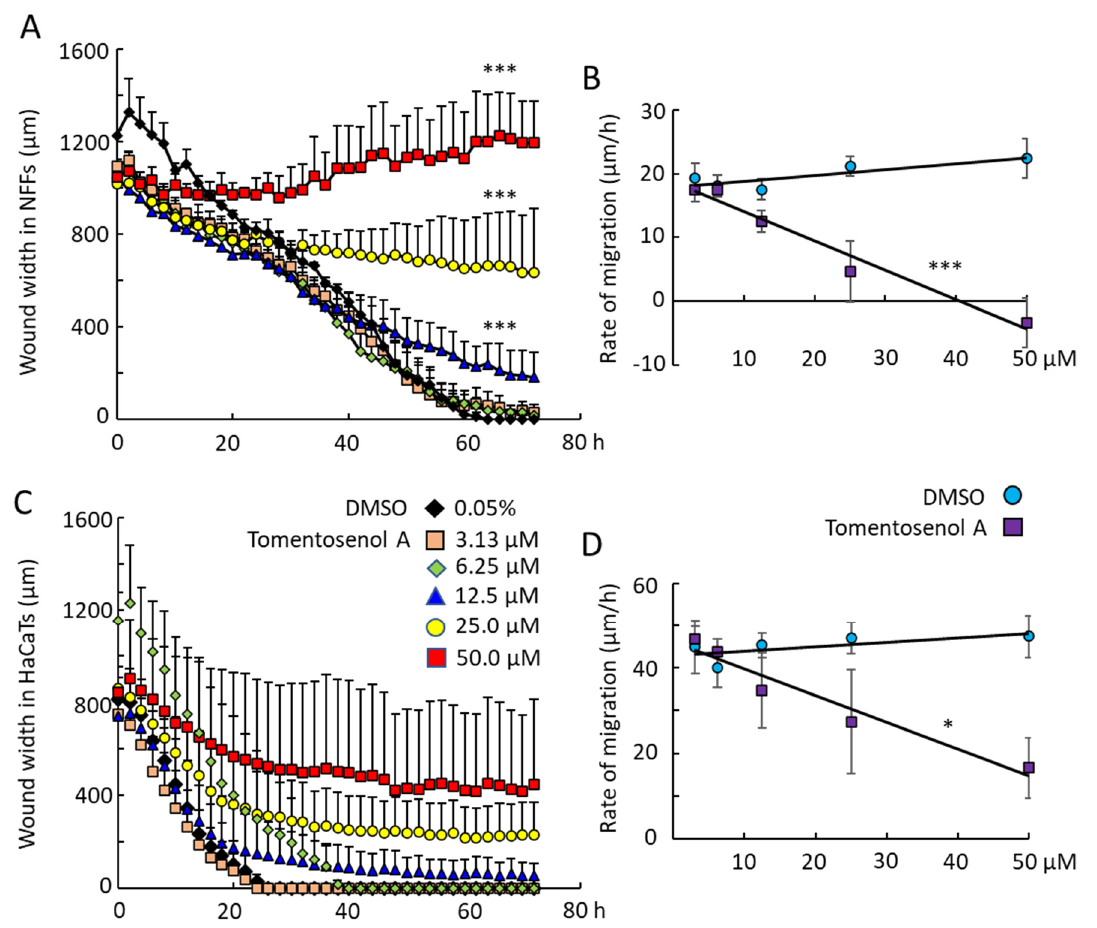
Figure 5. Effects of Compound 1 on scratch wound repopulation by neonatal human foreskin fibroblasts (NFFs) ( A , B ) and immortalized keratinocytes (HaCaTs) ( C , D ) incubated with Compound 1 for 72 h. Data were analysed for wound width ( A , C ) and rate of cell migration into the wound region ( B , D ). The small negative rate of migration observed for 50 µM Compound 1 with NFF indicates an expansion in wound area during the treatment period. Data shown are mean ± SEM for n = 3 independent experiments. * p < 0.05; *** p < 0.001, with comparison to DMSO control ( A , C ), 0.05% DMSO; ( B , D ), 0.0031 − 0.05% DMSO). Data were analysed using a two-way ANOVA with repeated measures.